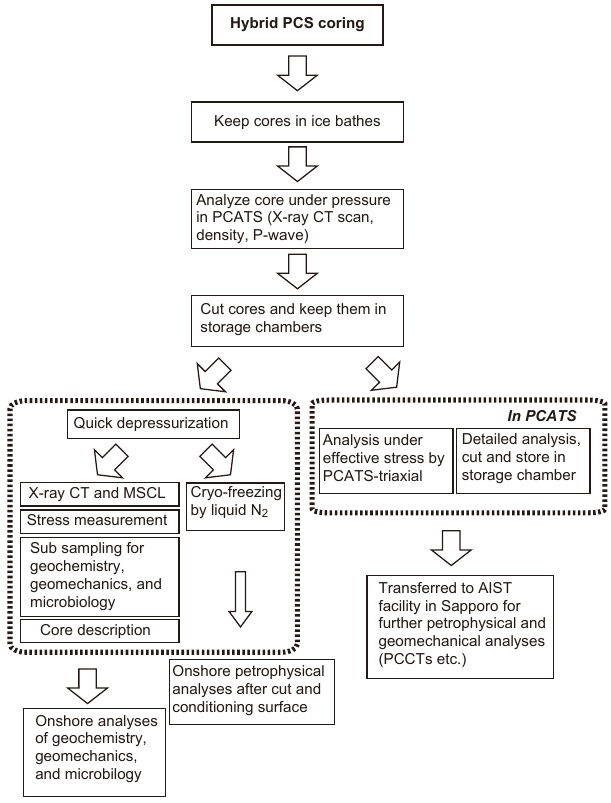
Table 3a. Coring summary of expedition 802.